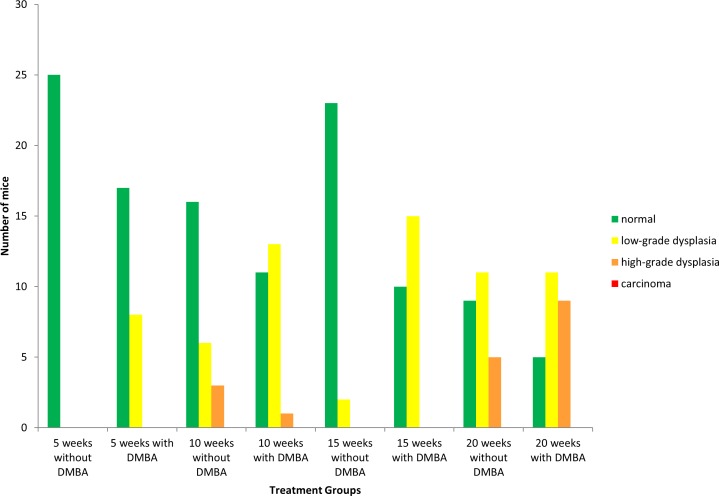
Histological analysis of the anal transition zone at various time points with and without DMBA in FVB/N mice.Anal histology identified by a trained pathologist for each time point (25 mice/group) following treatment with and without DMBA (0.12μmole topically to anus weekly). There is evidence of increased number of animals with high-grade dysplasia, however overt carcinoma is not seen with increasing treatment times with DMBA in mice without HPV oncogenes.